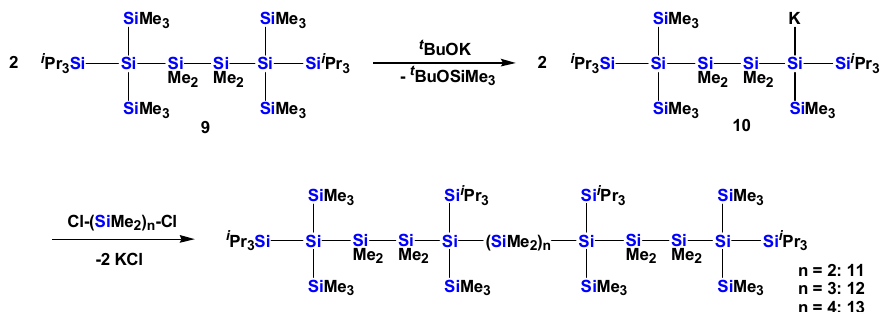
Scheme 3. Synthesis of elongated oligosilanes with trimethylsilyl and triisopropylsilyl substituents the core and at the periphery of the chains. in the core and at the periphery of the chains.